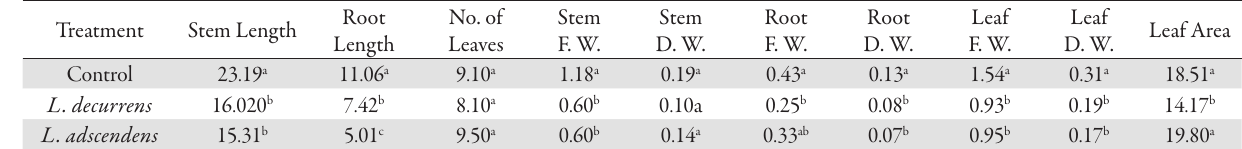
Tab. 4. Effect of Ludwigia decurrens and L. adscendens exudates on vegetative parameters of Corchorus olitorious at week 6